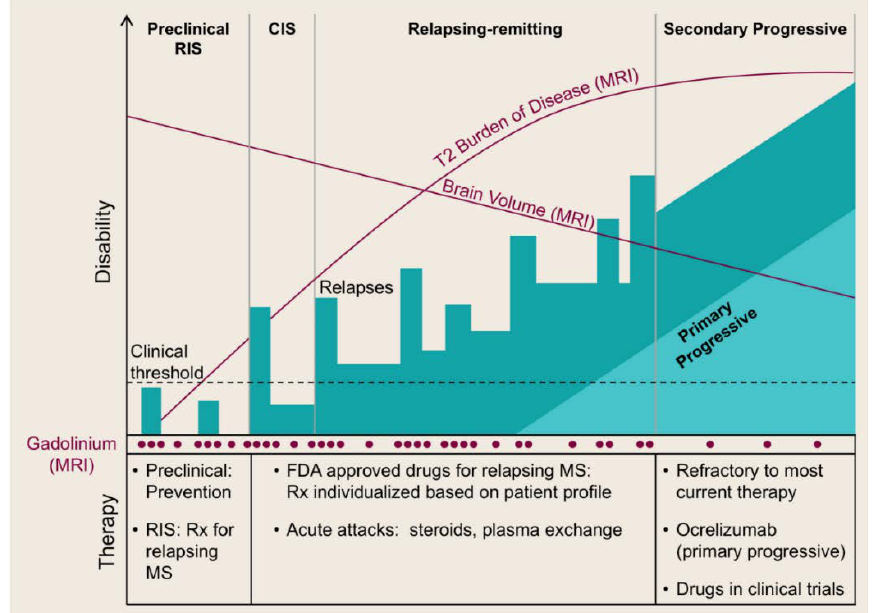
Figure 1. Stages of multiple sclerosis (MS). RIS: radiologically isolated syndrome; CIS: clinically isolated syndrome; FDA: U.S. food and drug administration (with the permission of